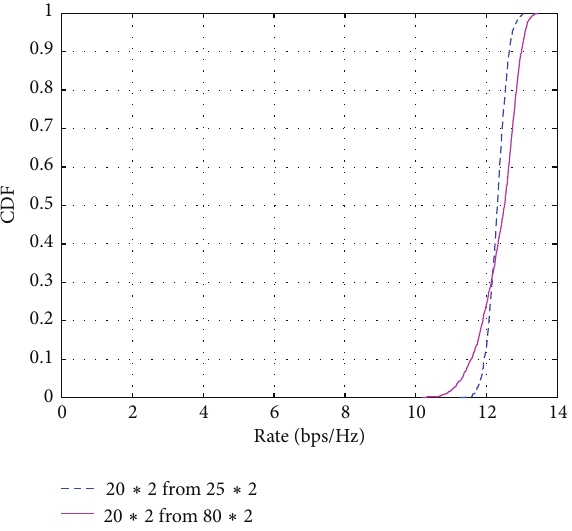
Figure 4: CDFs of rates for various 𝑀 𝑠 for a MIMO with a fixed 𝑀 𝑡 .